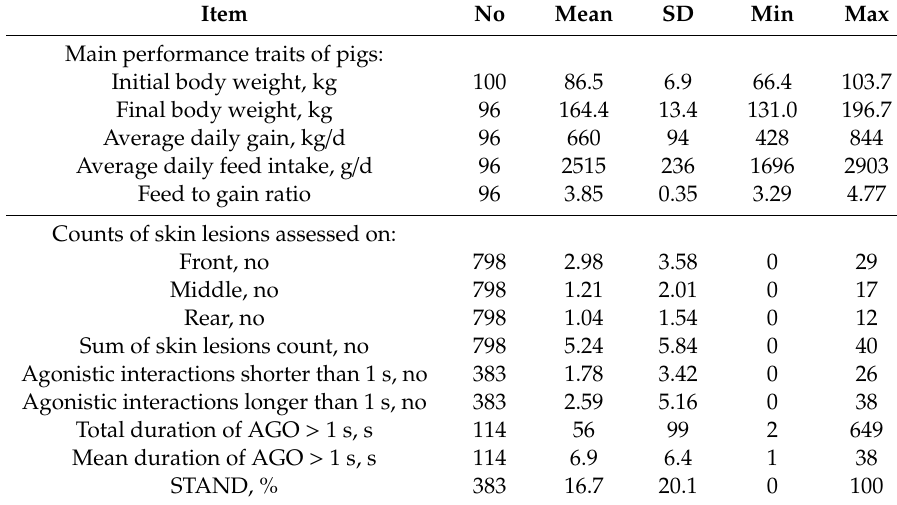
Table 1. Descriptive statistics of main performance traits of growing pigs and of skin lesions count, number of agonistic interactions shorter and longer than 1 s (AGO > 1 s), total and mean duration of AGO > 1 s, and incidence of standing pigs on total number of pigs in the pen (STAND). Item